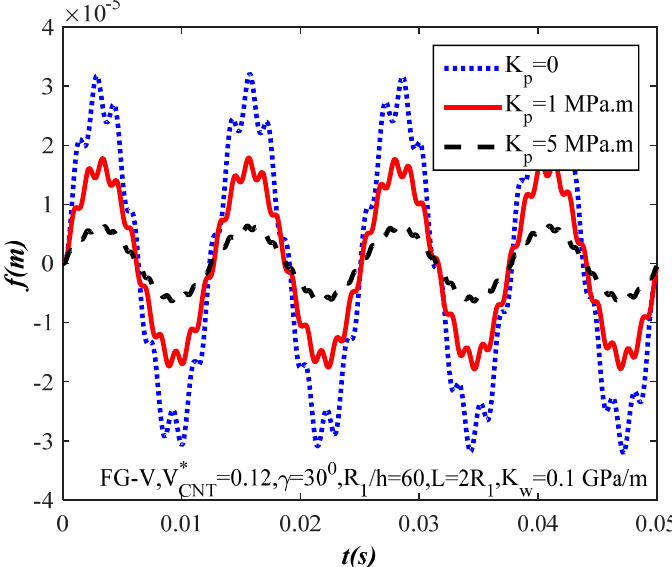
K on the dynamic response of the FG- p